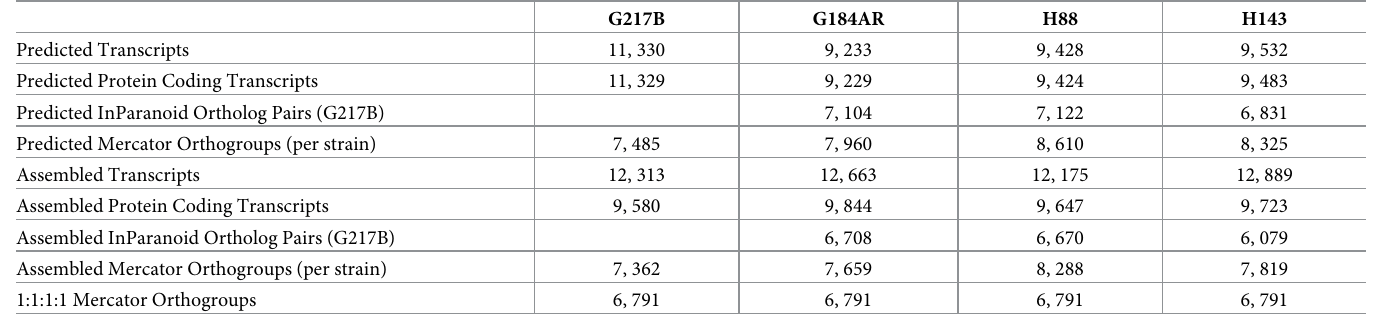
Table 1. Comparison of numbers and orthology mapping methods of assembled and predicted transcripts.